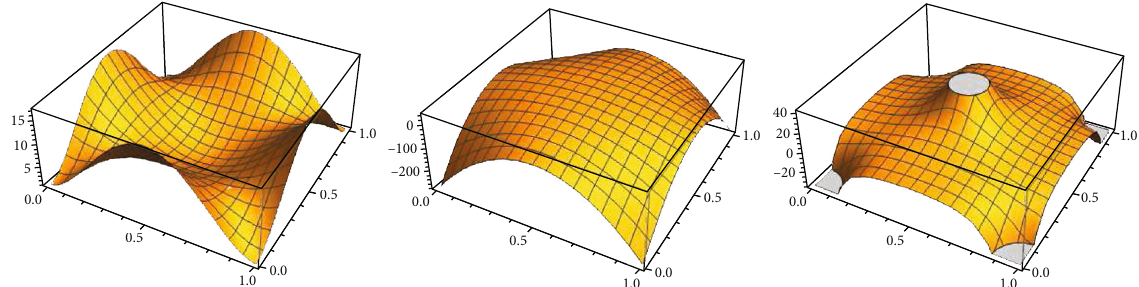
= β / α 0 0 are shown. 0